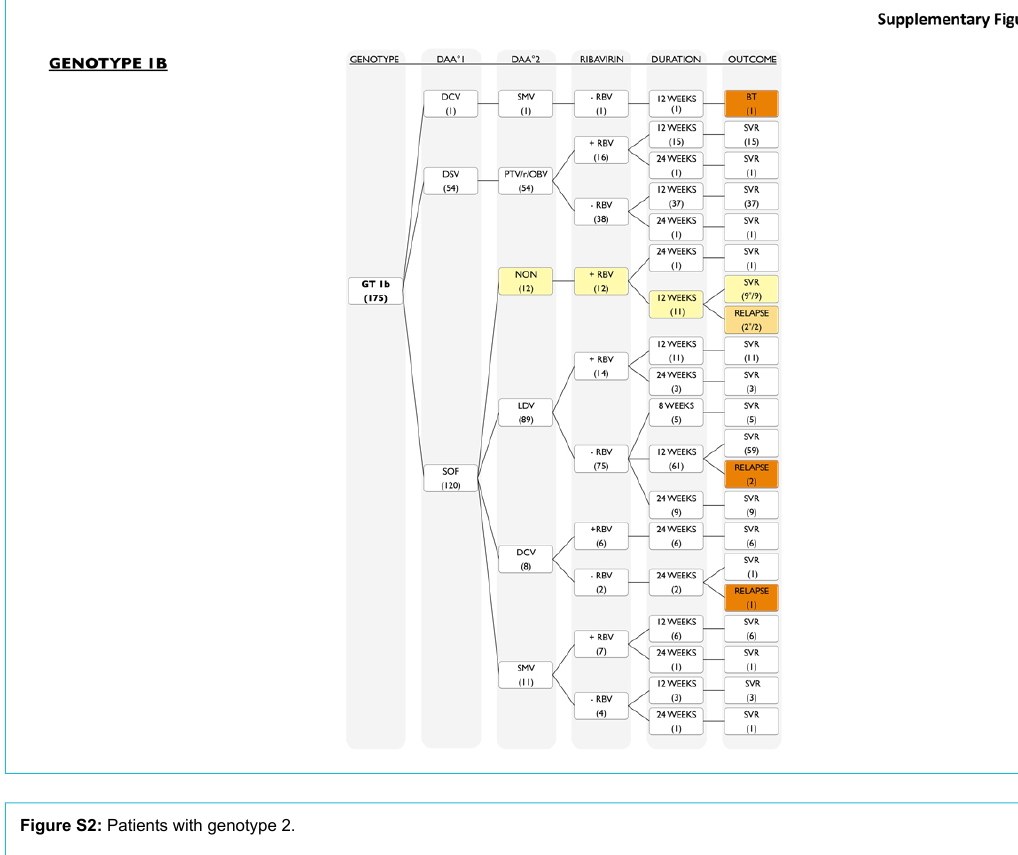
Figure S2: Patients with genotype